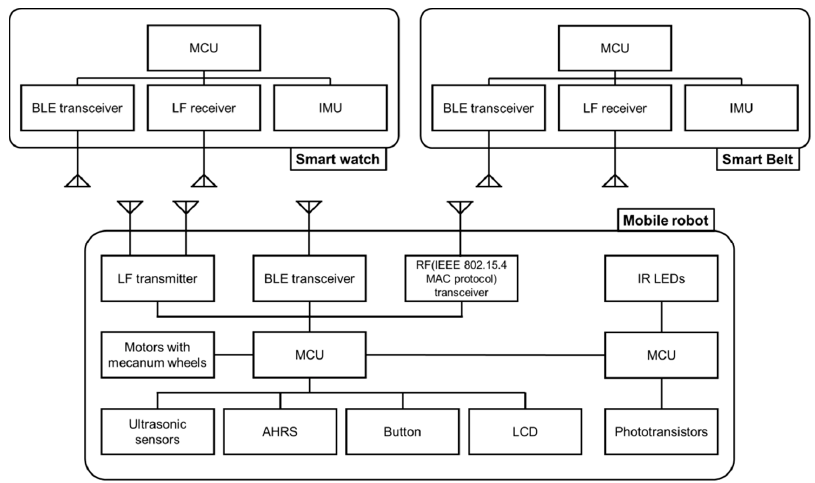
Figure 14. Pet-Bot system’s hardware configuration.